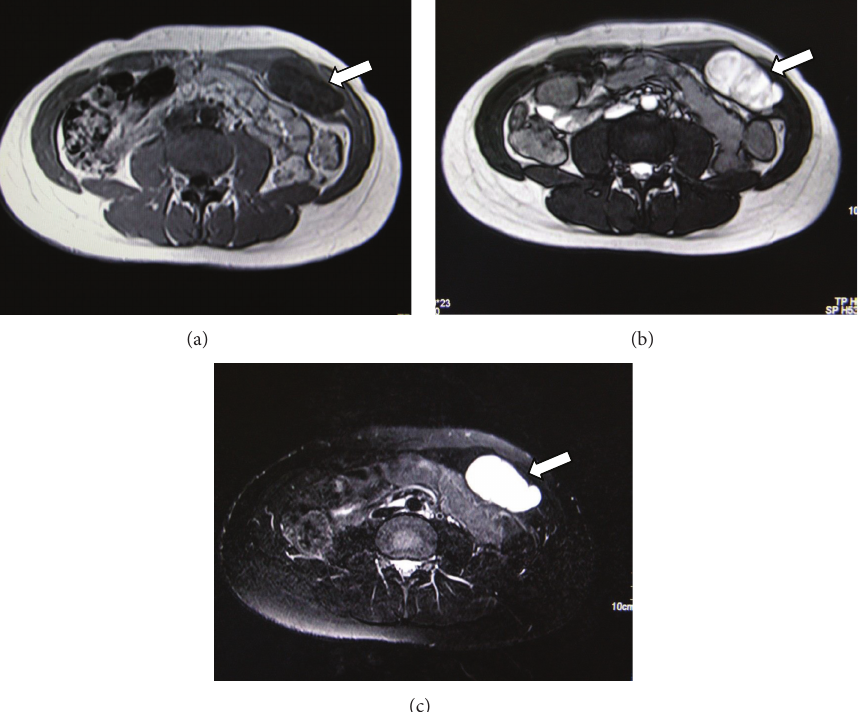
Figure 2: (a) T1W MRI shows encapsulated superficial mass with marked heterogeneity and patchy hypointense foci (arrow) suggesting cystic degeneration. (b) T2W MRI clearly delineates the capsule of the lesion and internal morphology (arrow). (c) The lesion is markedly hyperintense on fat-suppressed MRI suggesting degeneration